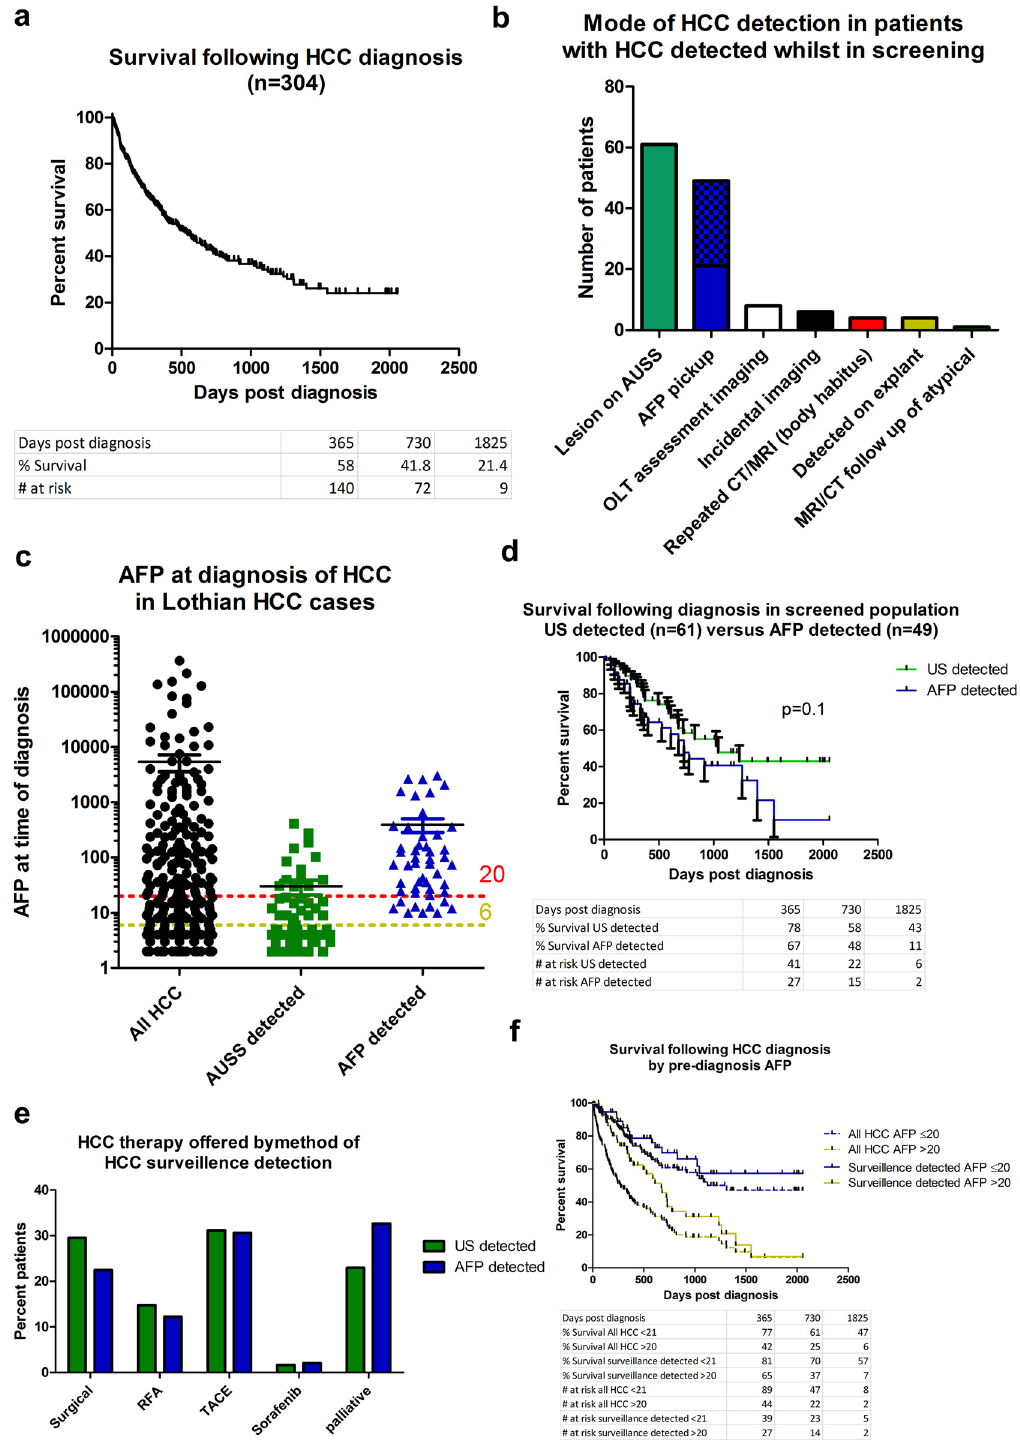
Fig 1. AFP as an HCC surveillance tool detects a significant number of treatable HCC in patients with satisfactory outcomes. A ) Survival for total HCC cohort diagnosed with HCC between 1/1/2009 and 31/12/2014. B ) The role of AFP in HCC detection. Method of HCC detection for the 133 patients within HCC surveillance programme at the time of diagnosis, chequered area within AFP pickup group represents the 28/49 patients in whom a recent US had not been performed — see text for details. C ) Individual AFP levels at time of diagnosis for patients diagnosed